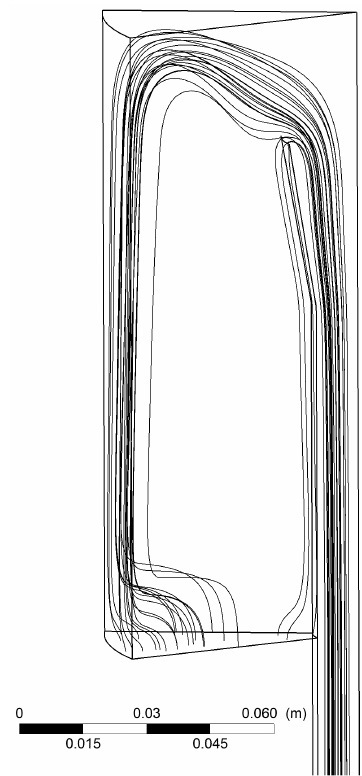
Fig. 1. A 30 ◦ radial section is used to model the flow through the inlet assembly with CFD. Air at − 40 ◦ C and 1µm diameter particles (density of 1000kgm − 3 ) are introduced through the opening at the bottom of the inlet. The outer surface and the inlet pipe in the centre (ending in a funnel at the top) are heated to 20 ◦ C. Trajectories of the 1µm particles are depicted as grey